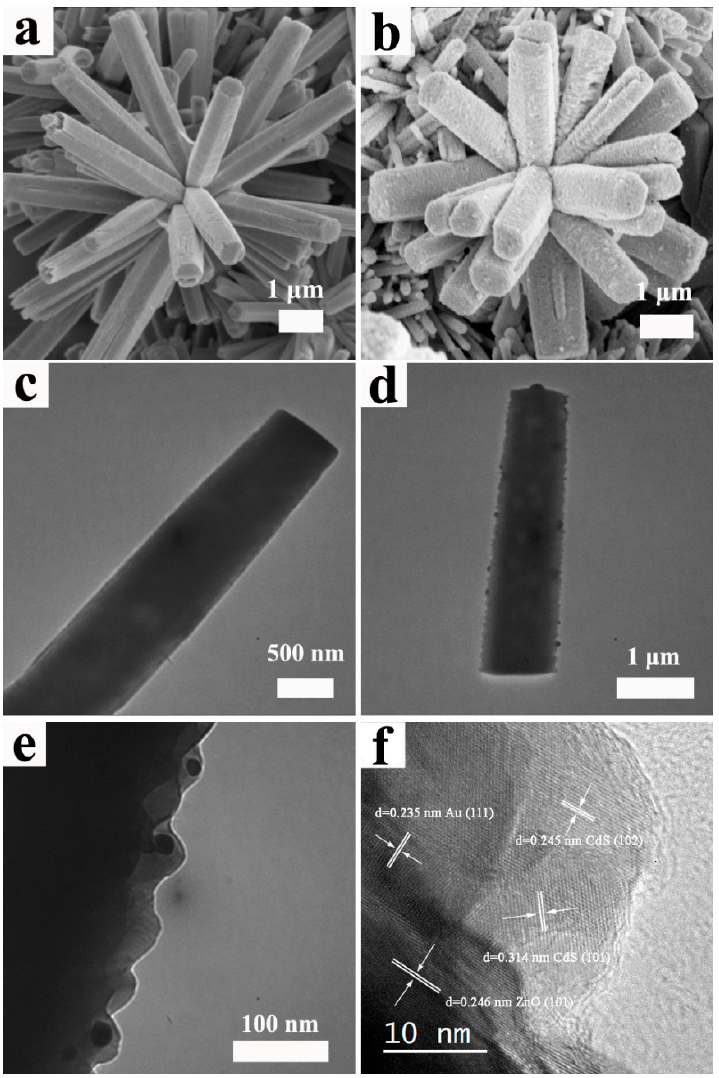
Figure 2. FESEM images of ( a ) ZnO sample and ( b ) ZnO/Au/CdS sample; TEM images of ( c ) ZnO sample and ( d , e ) ZnO/Au/CdS sample; ( f ) HRTEM image of ZnO/Au/CdS sample.